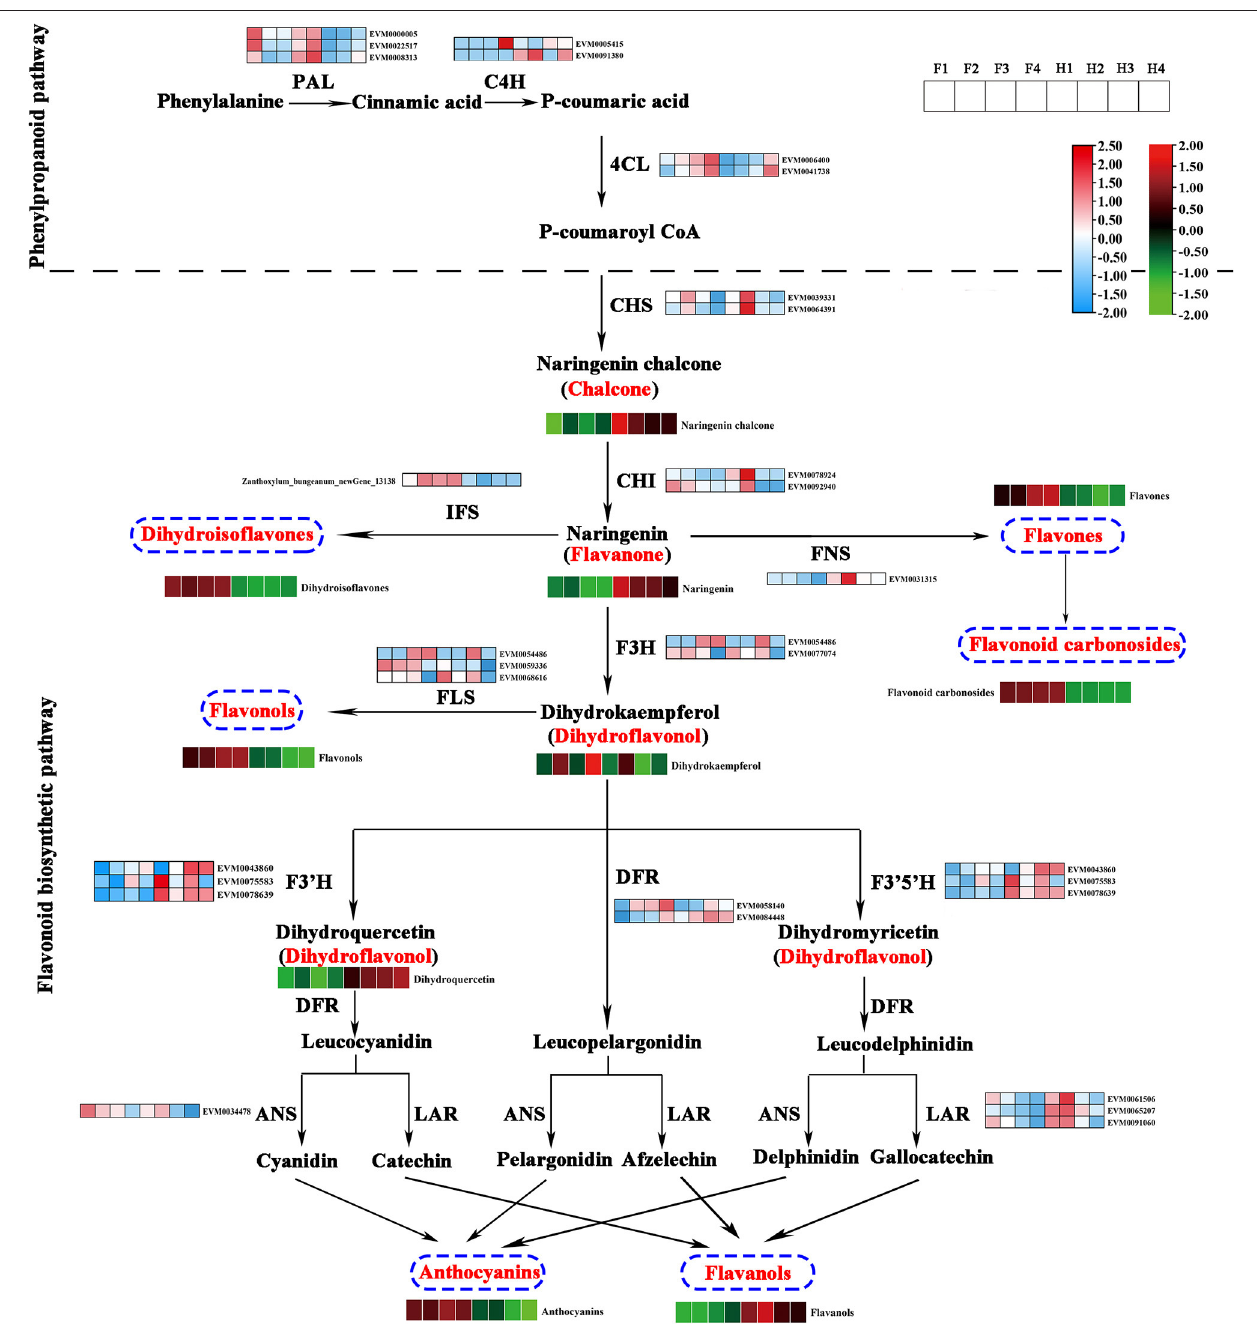
FIGURE 5 | Flavonoid biosynthesis pathway in ZBLs from two cultivars under drought stress. Gene expression is displayed in heatmaps based on the mean FPKM of three biological replicates; blue indicates low expression, and pink represents high expression. Flavonoid content is shown in heatmaps based on the abundance in the metabolite profile. Flavonoids with high abundance are indicated in red, and those with low abundance are indicated in green. PAL, phenylalanine ammonia lyase; C4H, cinnamate 4-hydroxylase; 4CL, 4-coumaroyl CoA ligase; CHS, chalcone synthase; CHI, chalcone isomerase; F3H, flavanone 3 β -hydroxylase; DFR, dihydroflavonol-4-reducatse; FLS, flavonol synthase; FNS, flavone synthase; LAR, leucoanthocyanidin reductase; ANS, anthocyanidin synthase; ANR, anthocyanidin reductase. FPKM values in the transcriptomic data, confirming the TF genes from the WGCNA co-expression network accuracy of the transcriptome data and repeatability of the were selected for qRT-PCR ( Figure 8 ). Their relative expression expression levels in qRT-PCR were consistent with their